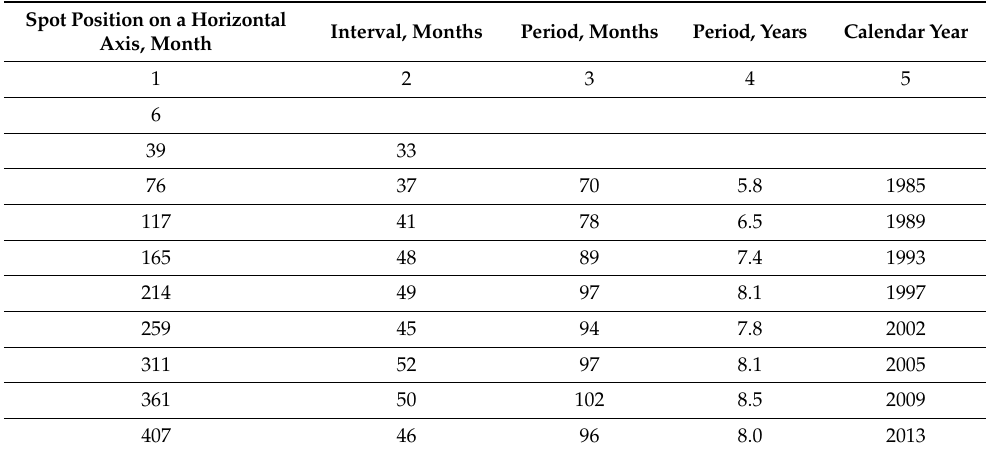
Table 1. Description of rhythms, which are exhibited in the wavelet-periodogram of the underground flow to the Southern Bug River.